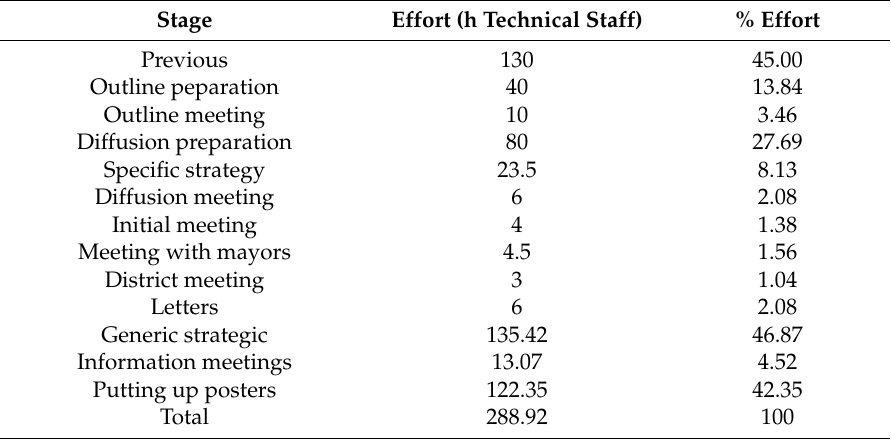
Table 8. Summary of diffusion cost by stage measured in technical staff working